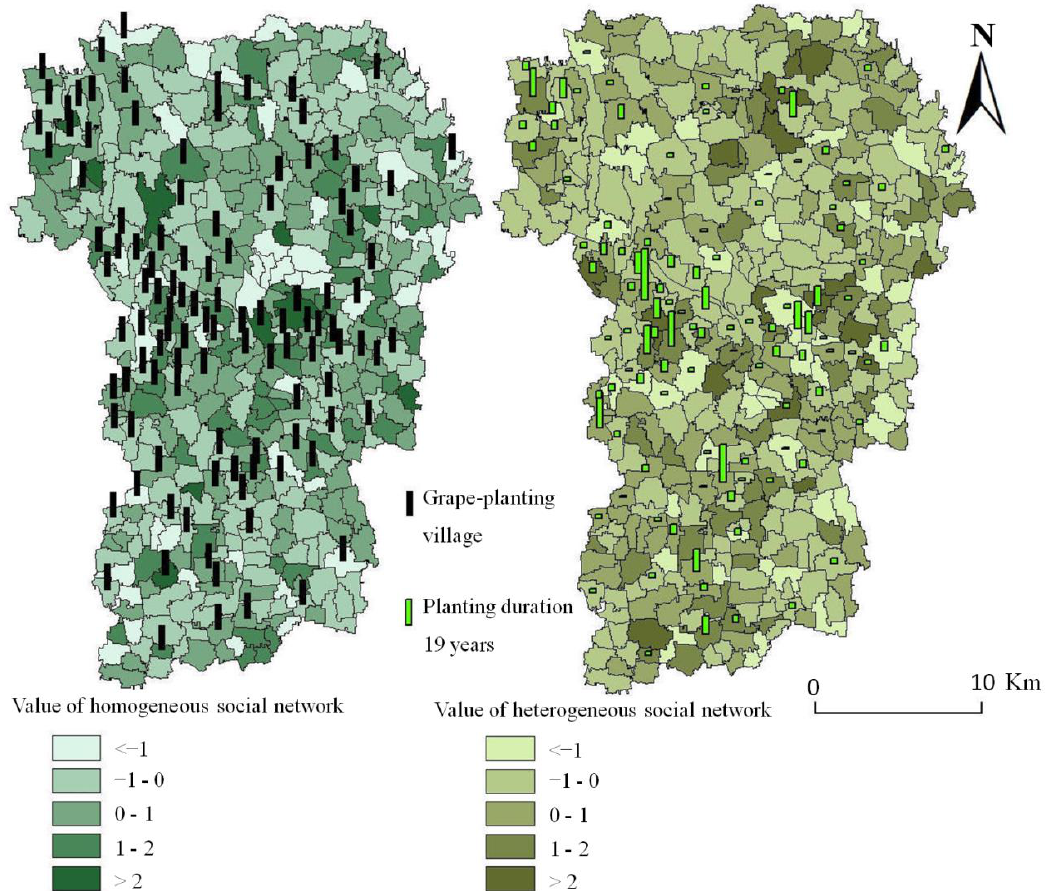
Figure 4. Spatial pattern of social network and crop specialization.